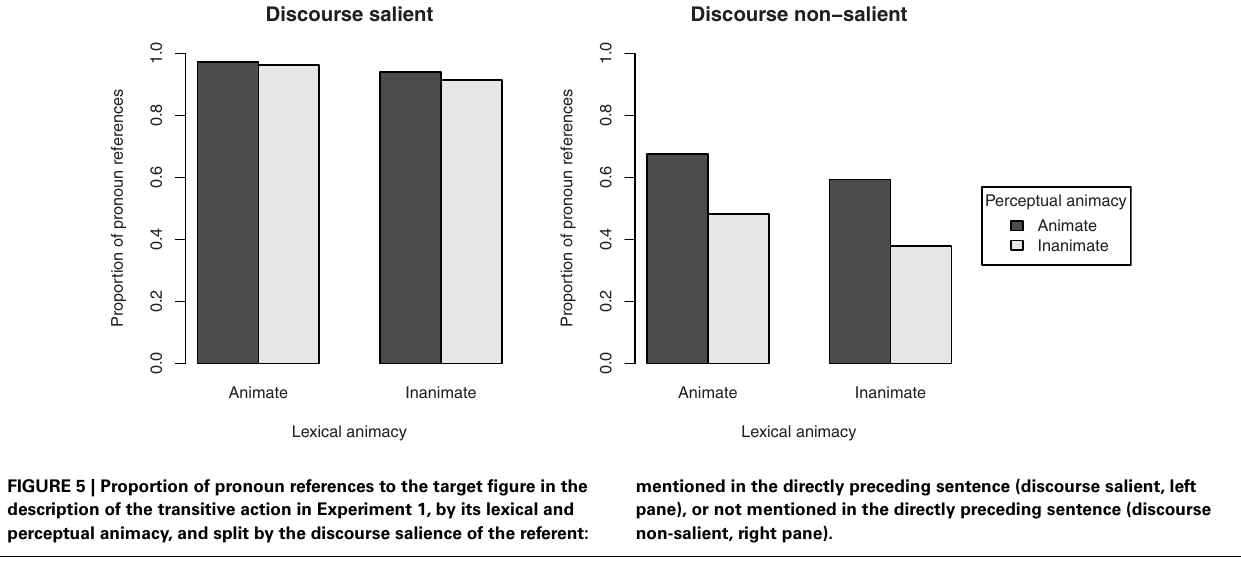
FIGURE 5 | Proportion of pronoun references to the target figure in the description of the transitive action in Experiment 1, by its lexical and perceptual animacy, and split by the discourse salience of the referent: